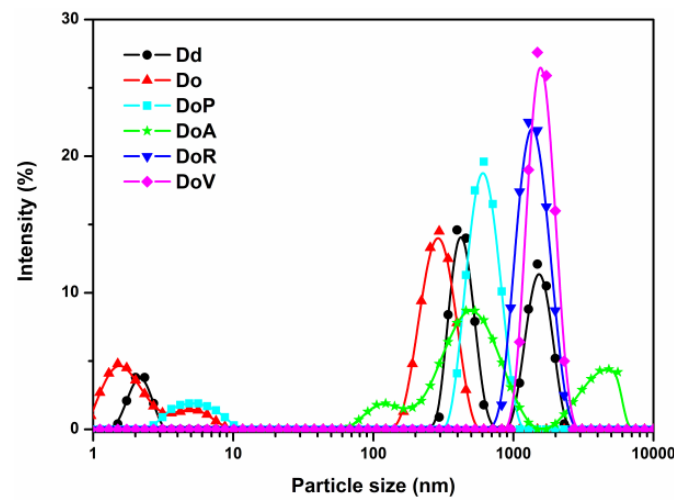
Figure 1. The particle size distribution of the sols.